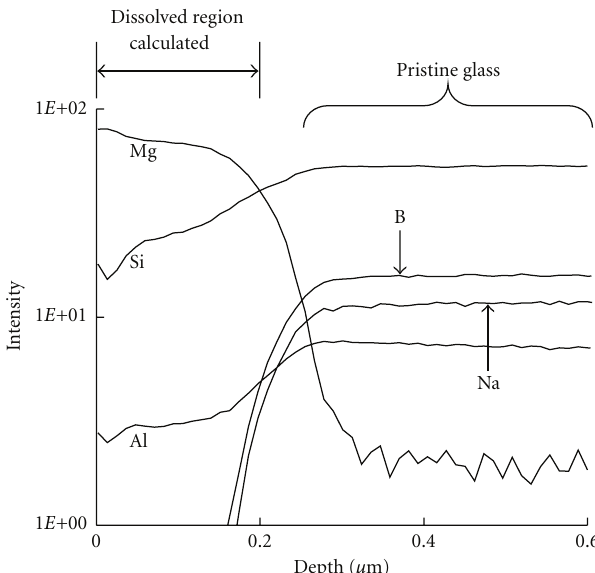
Figure 4: SIMS elemental depth profiles at the surface of the glass leached in MgCl 2 solution at 60 ◦ C for 36